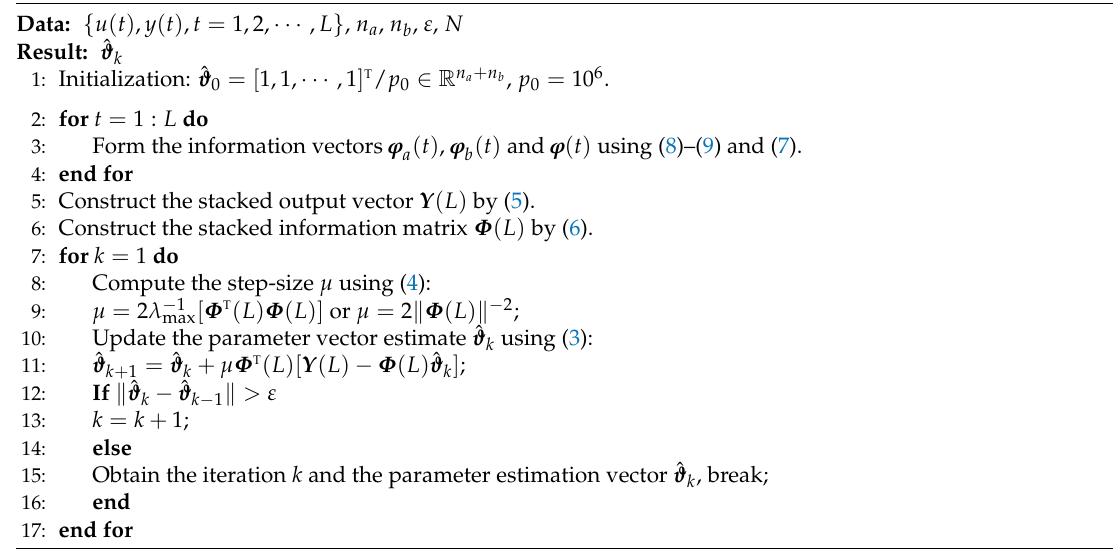
Algorithm 1 The pseudo-code of implementing the gradient-based iterative algorithm.